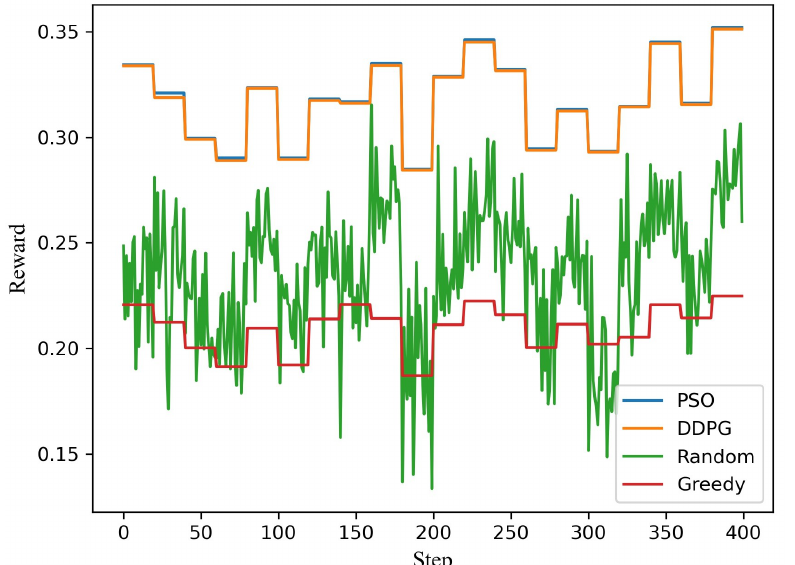
Figure 5. The system reward distance for each step for 5 pairs of users, comprising 10 users in